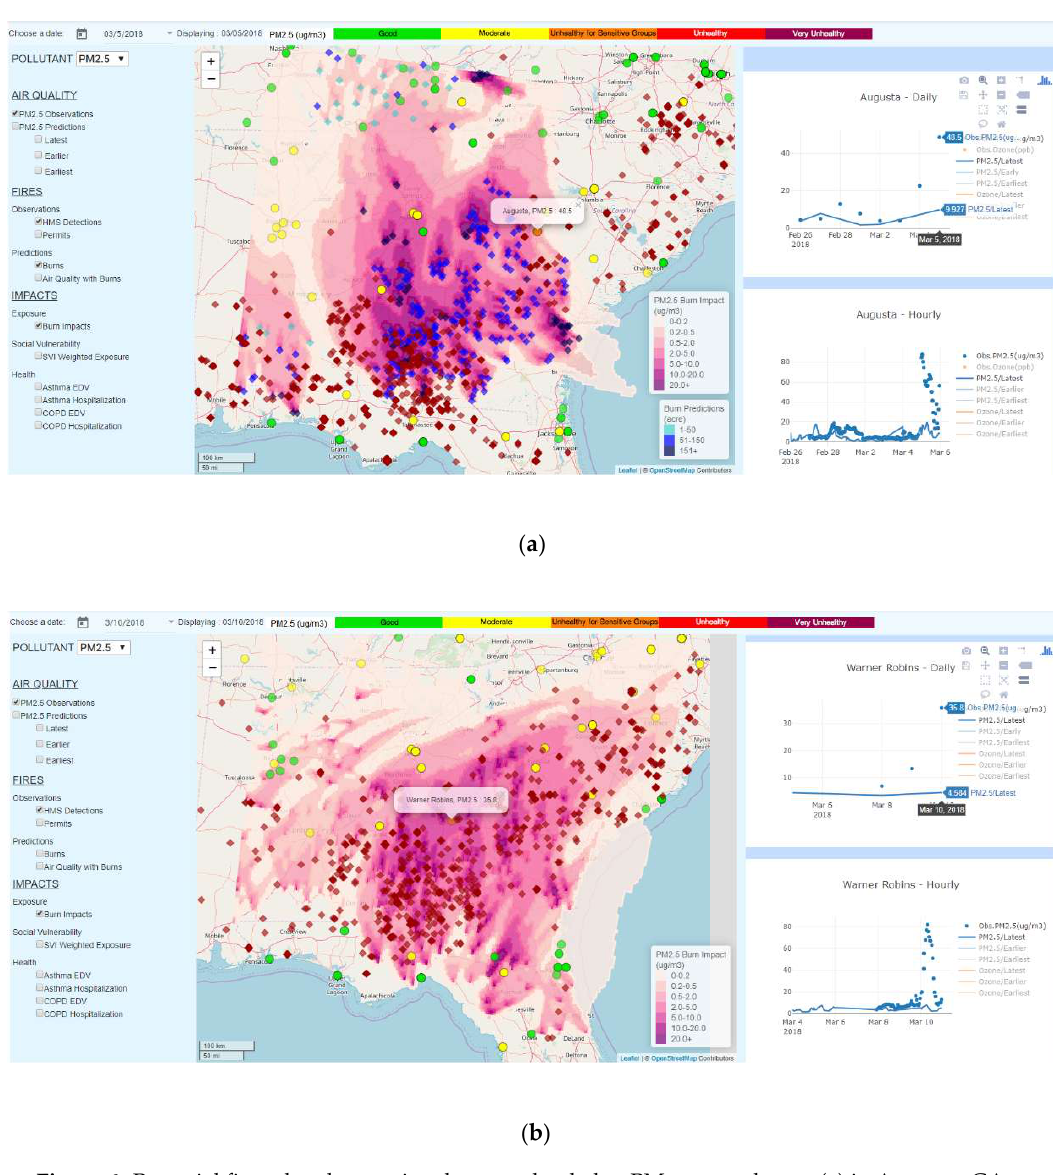
Figure 6. Potential fire-related exceptional events that led to PM 2.5 exceedances ( a ) in Augusta, GA on 5 March 2018 and ( b) in Macon, GA on 10 March 2018.